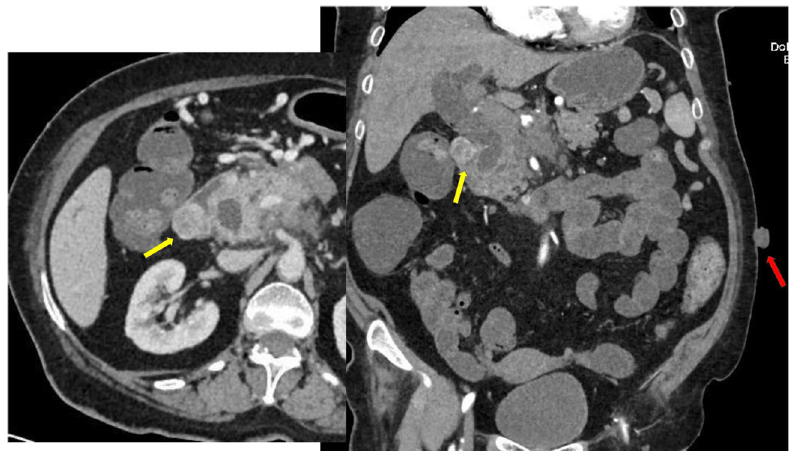
Fig. 6 A 55-year-old female with systemic NF1 patient presenting a cholangitis. Dual-phase contrast- enhanced CT scan reveals a pari- etal pariampullary duodenal nod- ule highly enhanced by contrast (yellow arrows). Neurofibromas of the abdominal wall are also found on CT scan (red